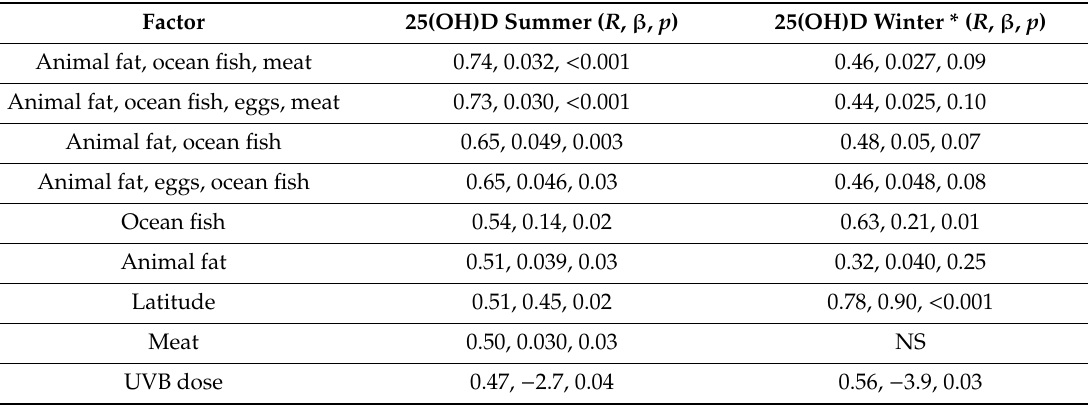
Table 5. Regression results for 20(OH)D concentration for 19 European countries from the European postmenopausal women’s study [22] with respect to dietary factors separately or in combination, latitude, and UVB